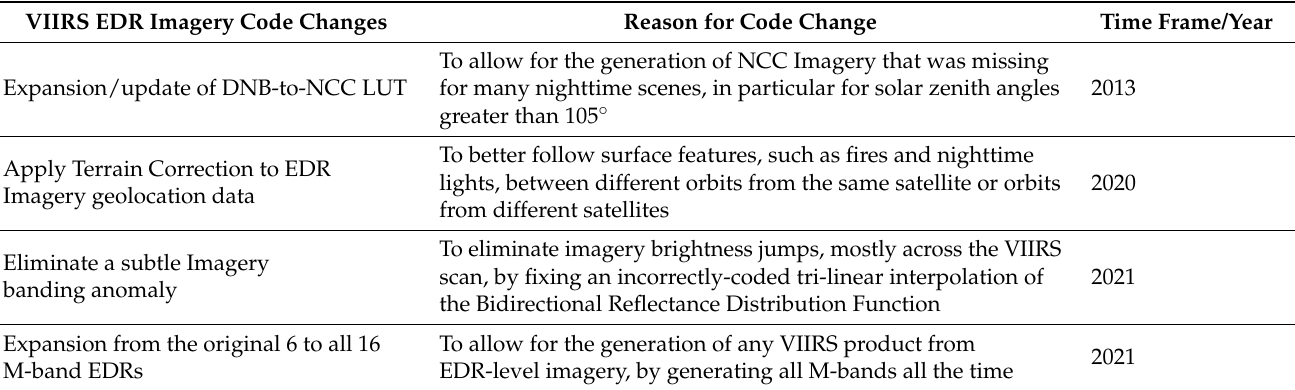
Table 2. Summary of major ground system software code changes for VIIRS EDR